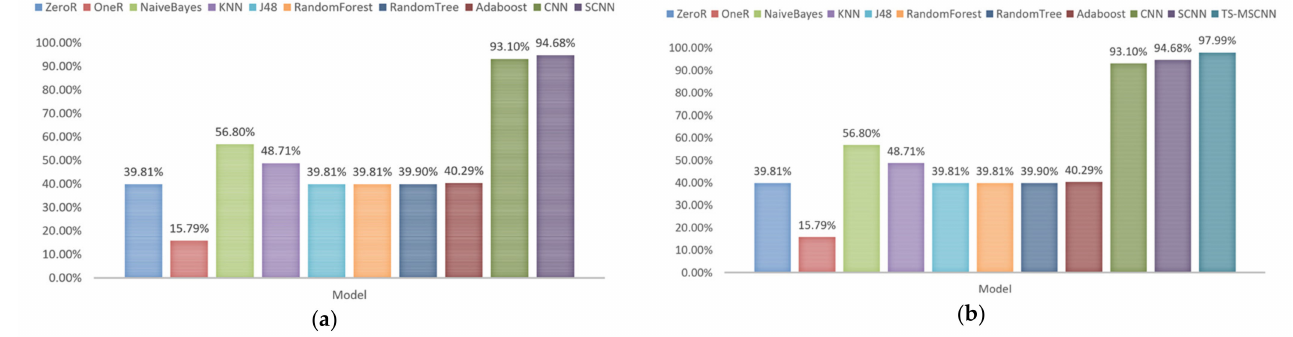
Figure 15. ( a ) Performance of the single model. ( b ) Performance of the TS-MSCNN and other